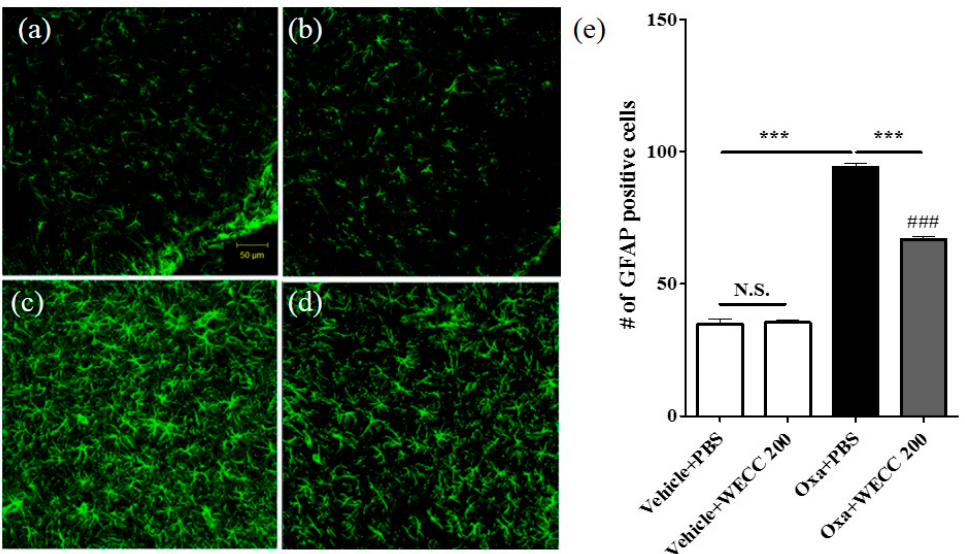
Figure 2. Immunohistochemical analyses of spinal astrocytes. Representative images of GFAP positive cells (astrocytes) in the spinal dorsal horn of Vehicle + PBS ( a ); Vehicle + 200 mg/kg WECC ( b ); Oxa + PBS ( c ); and Oxa + 200 mg/kg WECC ( d ) groups; ( e ) Quantification results of GFAP positive cells in the four groups. n = 6 per group. Data are presented as mean ± SEM. N.S.: non-significant; *** p < 0.001 vs. indicated group; ### p < 0.001 vs. Vehicle + PBS by one-way ANOVA followed by Bonferroni’s